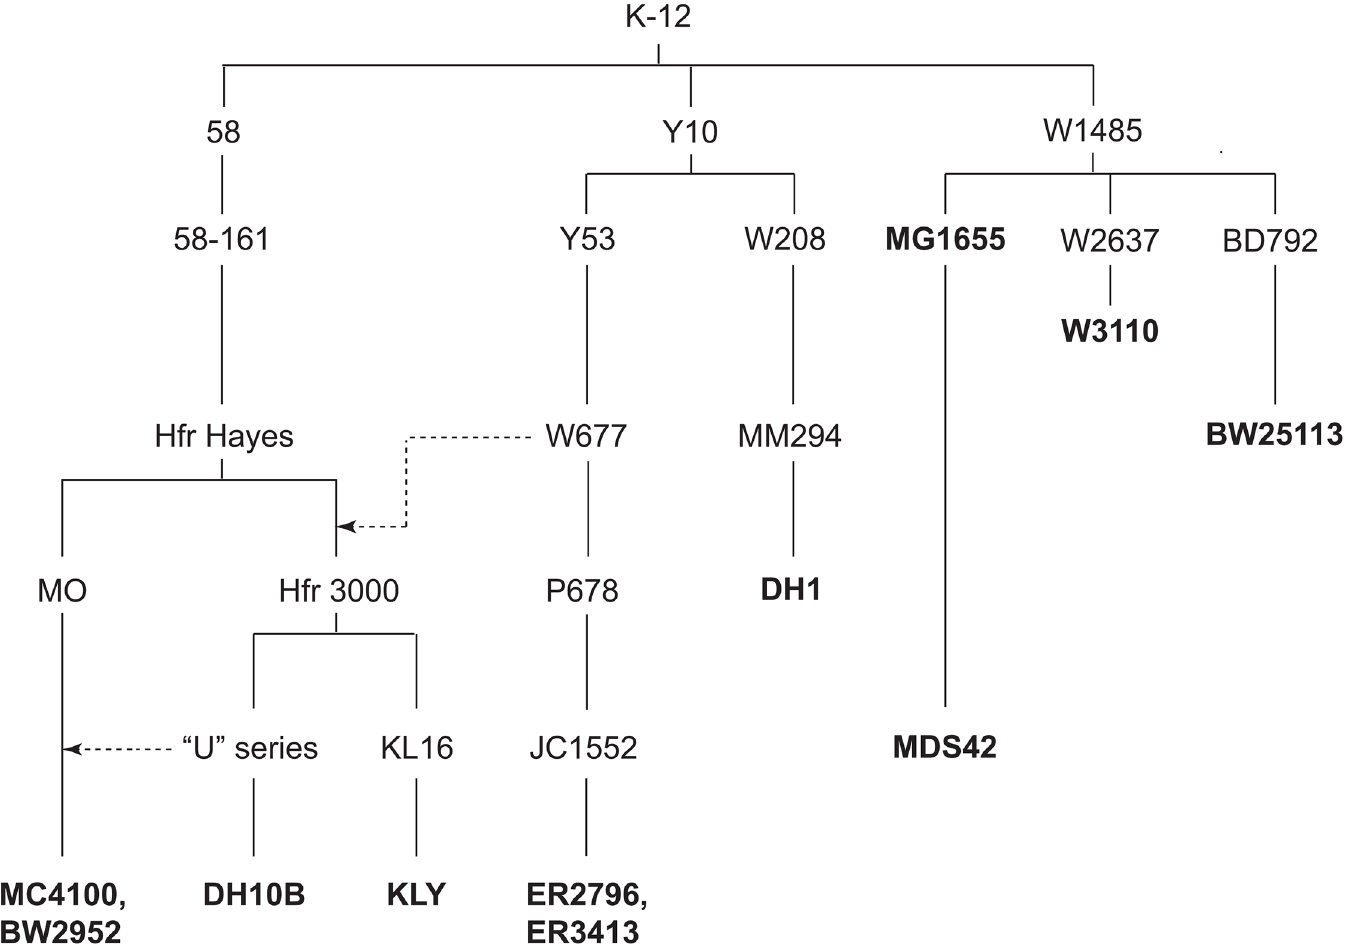
Fig 1. Relationship of ER2796 and ER3413 to the nine other completely sequenced E . coli K-12 strains. Completely sequenced strains are shown in bold type, and selected ancestral strains in Roman type. Most of the tree has been abstracted from Bachmann [28], except for the ancestries of MC4100 and DH10B back to Hfr Hayes, which are based on Laehnemann [63] and Durfee [4], respectively. Selected additional contributions of genetic material via crosses are shown by dotted lines. It appears based on genotype that Hfr 3000 U482 is the “ U series ” ancestor of DH10B, while Hfr 3000 U169 contributed genetic material in the ancestry of